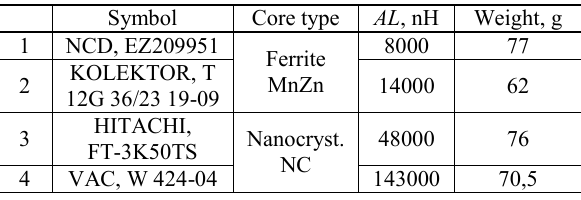
Fig. 1. Schematic diagram of the proposed measuring stand for active EMI filters . Table 1. Parameters of cores used for filter